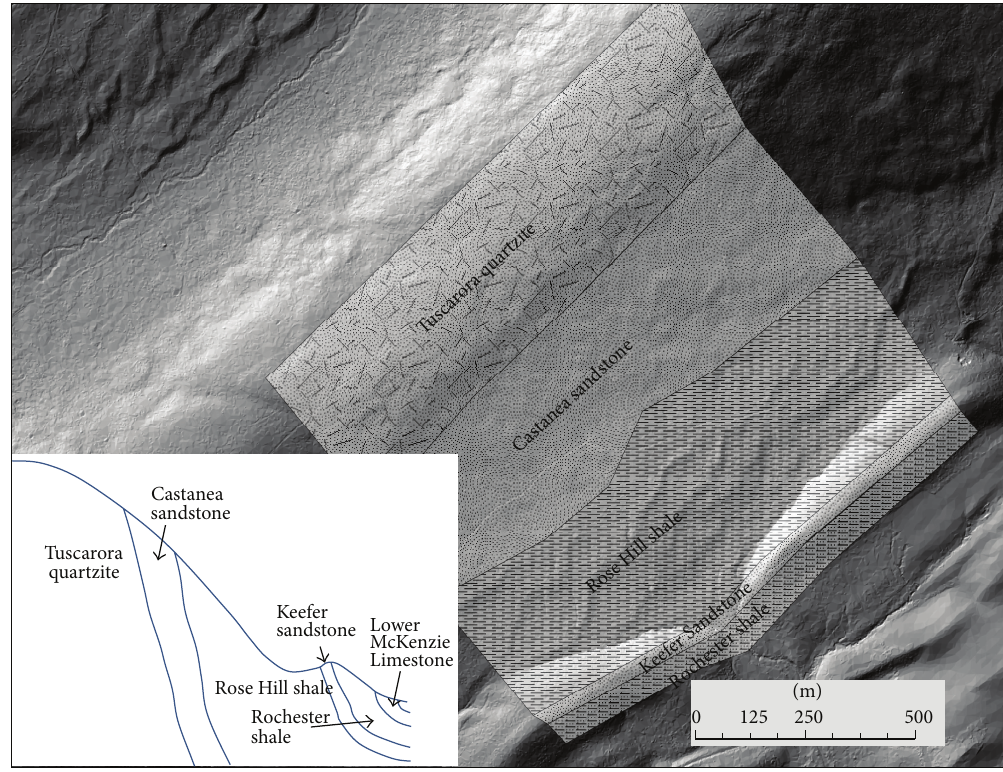
Figure 2: Map of the watershed showing approximate locations of contacts and the approximate arrangement of geology in the Leading Ridge Watershed 1 (adapted from shields 1966 [39]). Rock formations are almost vertical in the